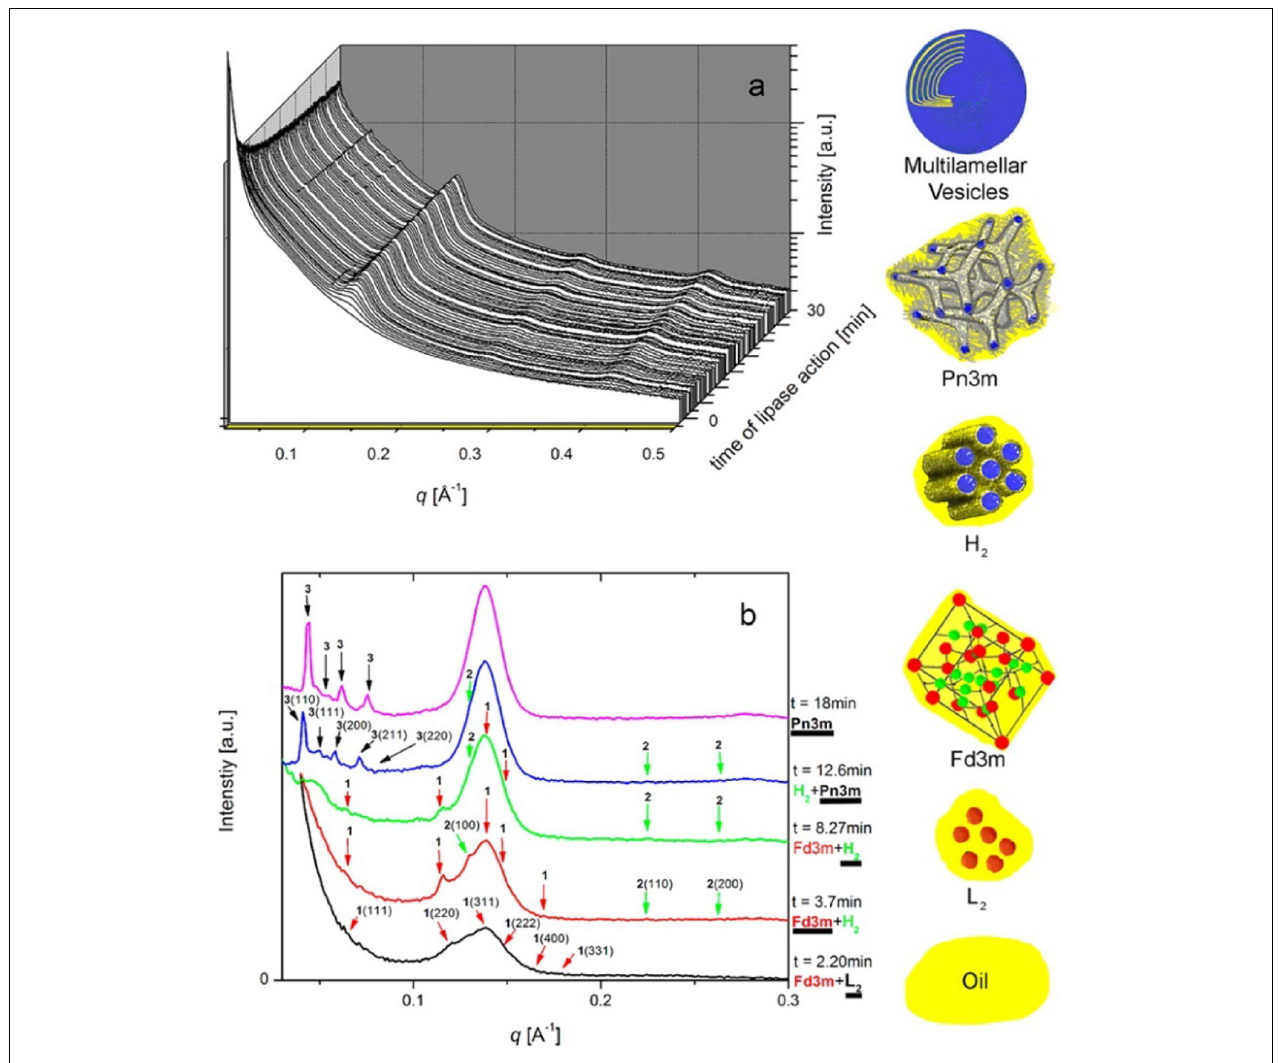
FIGURE 10 | (A) A 3D waterfall plot of the scattering profiles obtained during the digestion of milk coupled to SAXS is presented. (B) Offset SAXS profiles of milk during digestion in the absence of bile salt is presented. The peaks corresponding to the various mesophases are indicated with colored arrows, with the corresponding schematic diagrams of the mesophases presented in order of appearance from bottom to top (excluding multilamellar vesicles). This figure was reproduced with permission from Salentinig et al. (2013). Copyright (2013) American Chemical